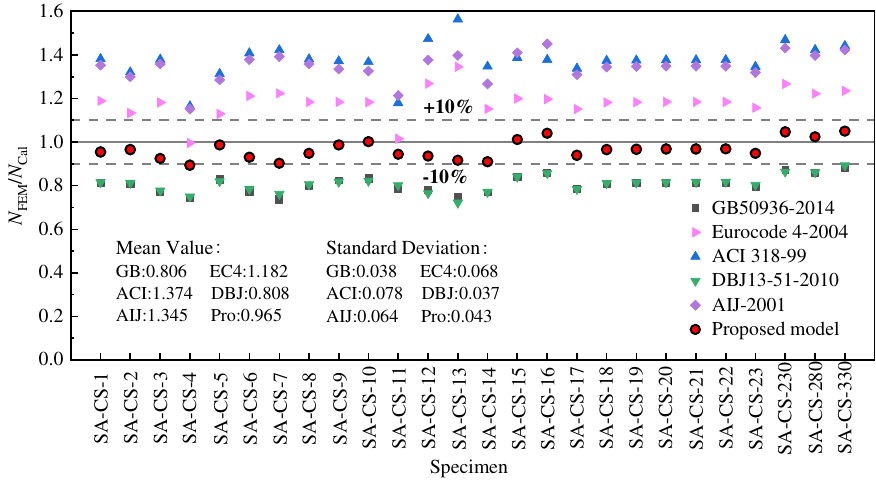
Figure 18. Comparison of N u-FEM / N u-Cal between existing codes and proposed design